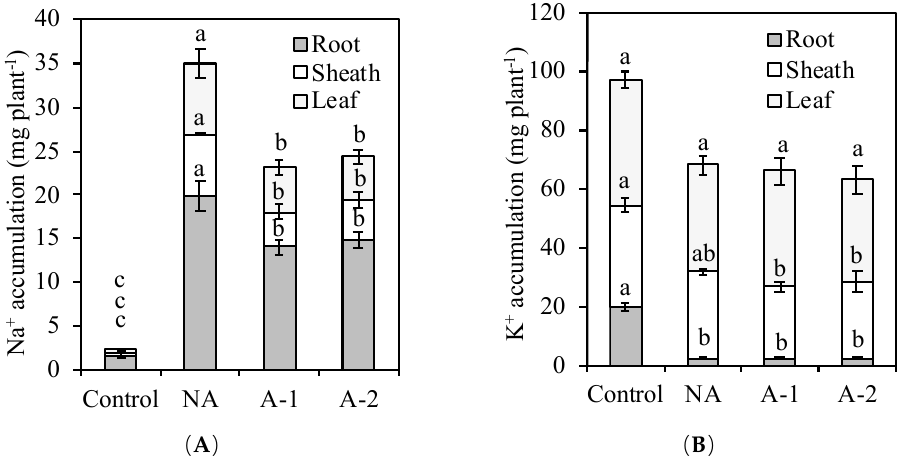
Figure 4. E ff ects of 10-days sodic-alkalinity with 100 mM NaHCO 3 on Na + accumulation ( A ) and K + accumulation ( B ) of pre-acclimated rye. Rye plants were pre-acclimated by 0 mM NaHCO 3 (NA) and 1 and 2 mM NaHCO 3 (A-1, A-2) for 10 days. Control plants were consistently irrigated by nutrient solution. Significance testing was performed using ANOVA analysis followed by Duncan’s multiple range test at p ≤ 0.05. The values are means (±SE) of five replicates. Means followed by the same letter are not significantly different.